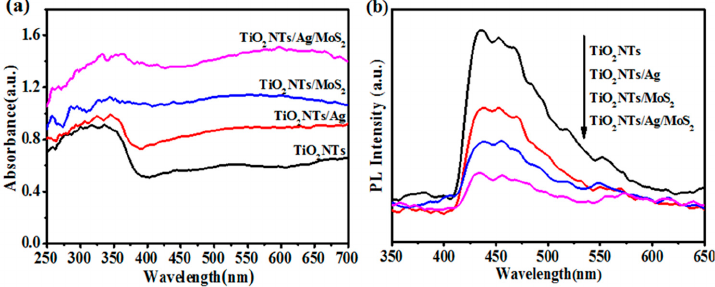
Figure 7. ( a ) UV-vis diffuse reflectance spectra; ( b ) PL spectra of TiO 2 NTs, TiO 2 NTs/Ag, TiO 2 NTs/MoS 2 , and TiO 2 NTs/Ag/MoS 2 .